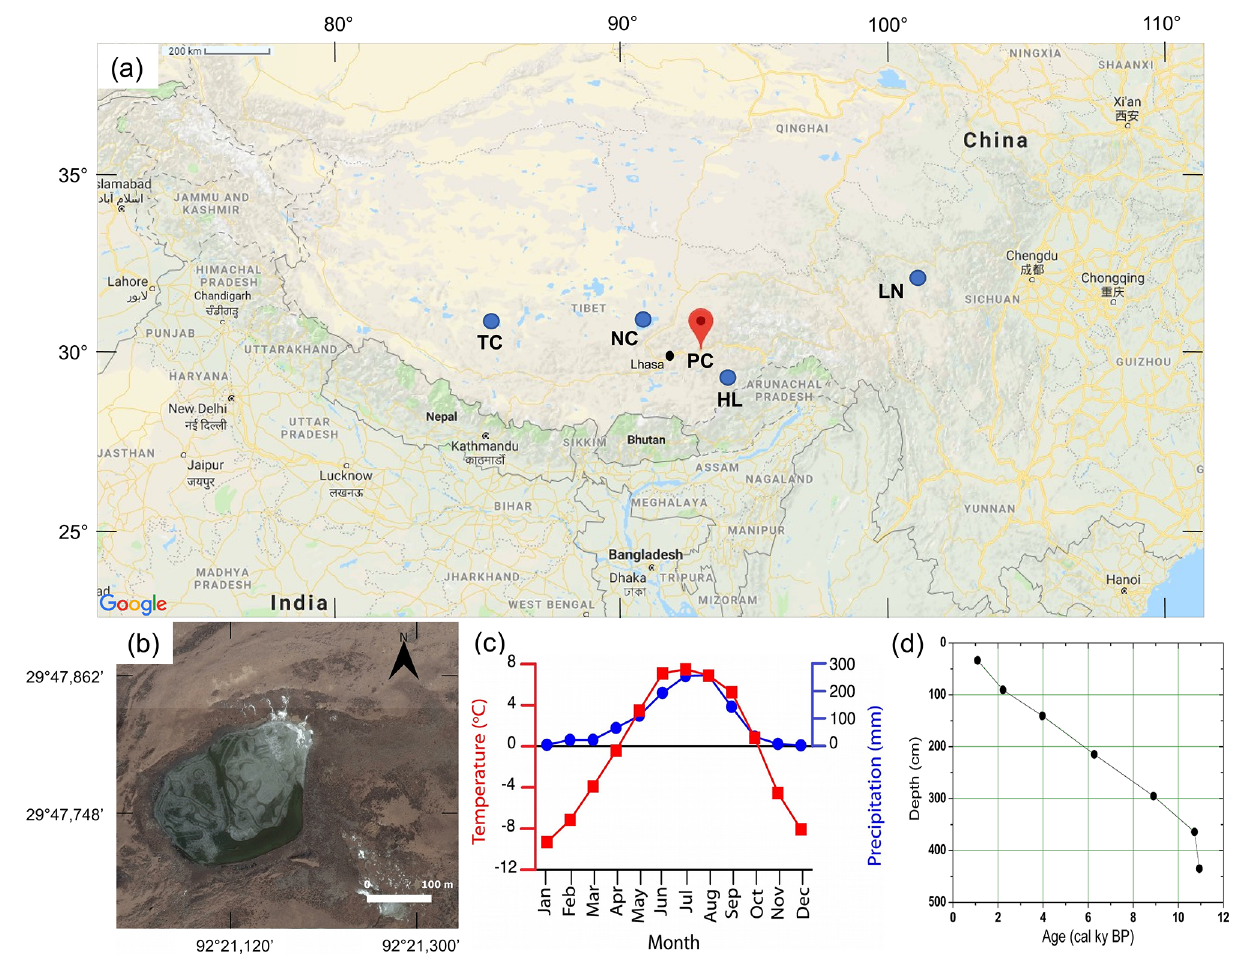
Figure 1. (a) Map of the Tibetan Plateau and surrounding territories showing the location of Paru Co (red pin) and of the other lakes mentioned in the text (blue circles): Taro Co (TC), Nam Co (NC), Hidden Lake (HL), and Lake Naleng (LN). (b) Satellite image of Paru Co. (c) Average monthly precipitation at Paru Co based on TRMM data from 1998 to 2007 and average monthly temperatures at Paru Co (4845ma.s.l.) from Lhasa (3650ma.s.l.) weather station data using a lapse rate of − 6.4 ◦ Ckm − 1 (Huffman et al., 2010). (d) Plot of the age–depth model for Paru Co according to Bird et al.